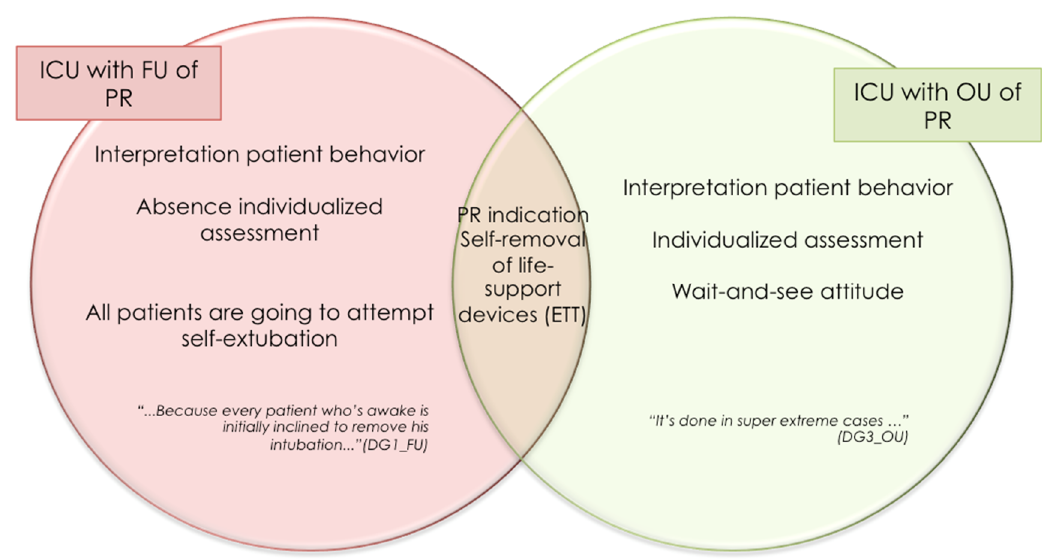
Figure 8. Venn diagram: influence of interpretation of patient behavior on the indication for use of physical restraints in intensive/critical care units with frequent versus occasional use of restraints. Abbreviations: PR: physical restraint; ETT: endotracheal tube; ICU: Intensive/critical care unit; OU: occasional/individualized use; FU: frequent/systematic use.